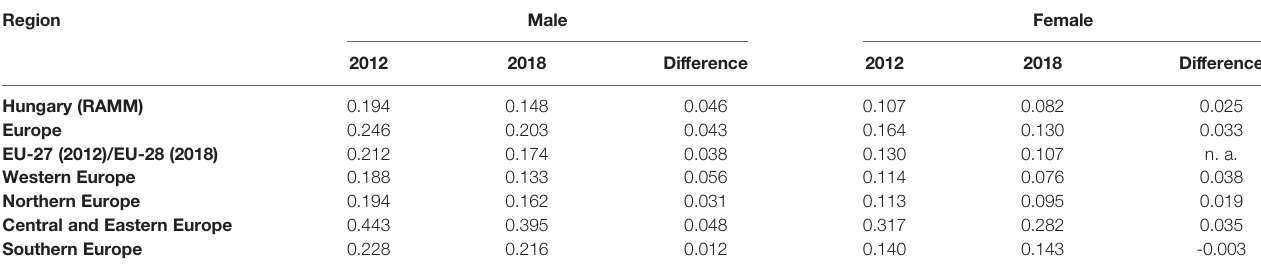
TABLE 1 | Mortality-to-incidence ratios of melanoma by sex in European regions in 2012 and 2018 using the European Standard Population 1976 dataset (4, 5). Region